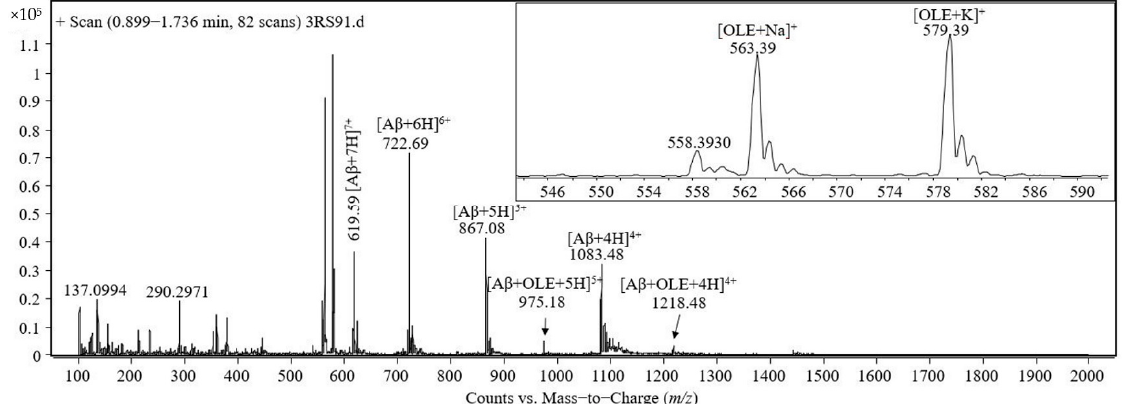
Figure 3. Mass spectrum obtained by ESI-triple quadrupole analysis of the equimolar solution containing 50 pmol/ µ L A β (1–40) and oleuropein in 1 mM ammonium bicarbonate, pH 7.35, incubated for 30 min at 37 ℃ .